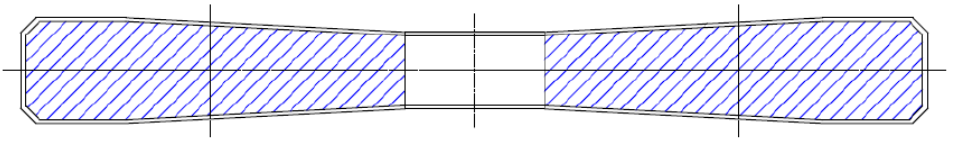
ff ective area of USP in the sleeper Figure 3. Effective area of USP in the sleeper PS-94. Figure 3. E